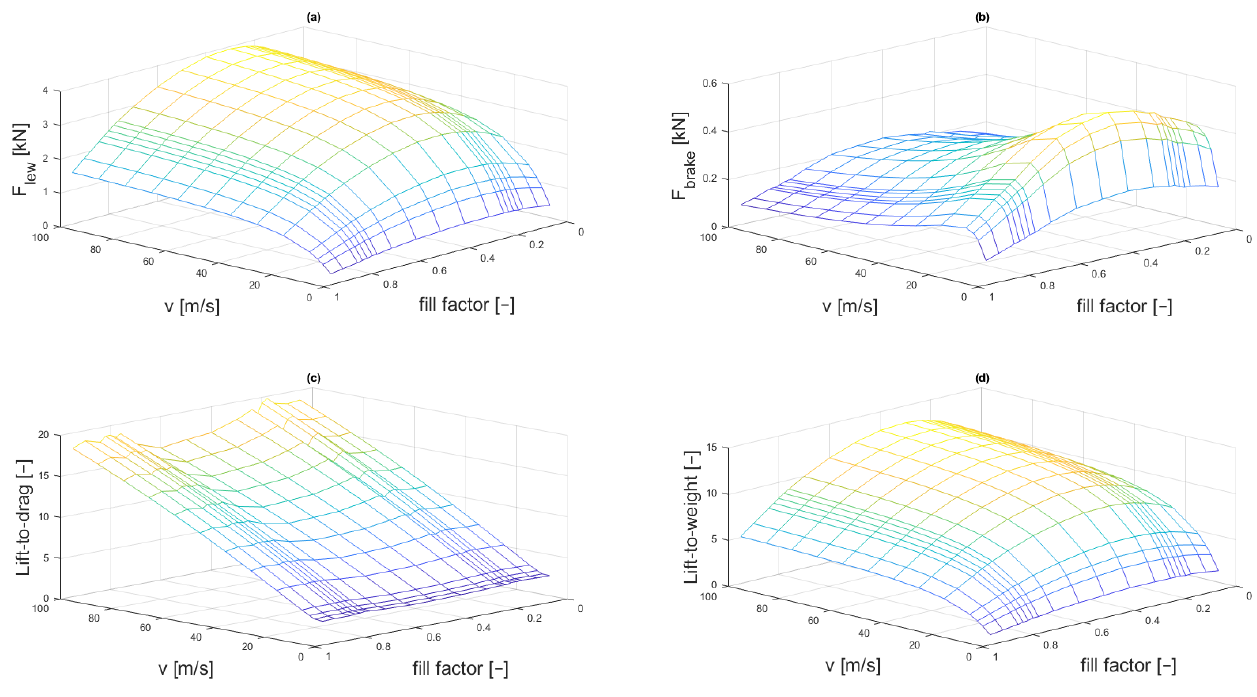
Figure 4. Results obtained from transient simulations. ( a ) Levitation force as a function of velocity and fill factor, ( b ) braking force as a function of velocity and fill factor, ( c ) lift-to-drag ratio as a function of velocity and fill factor and ( d ) lift-to-weight as a function of velocity and fill factor.